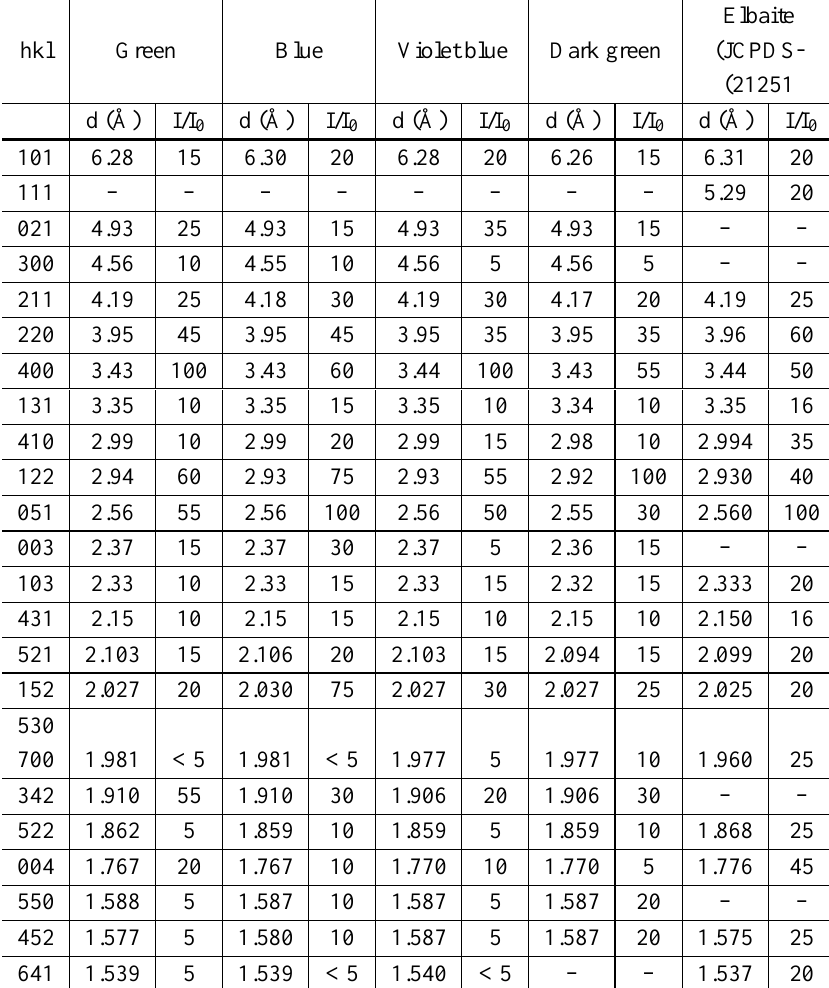
Powder diagram of gem-quality tourmalines from the Alto Quixaba pegmatite. Data for elbaite of the JCPDS is shown for